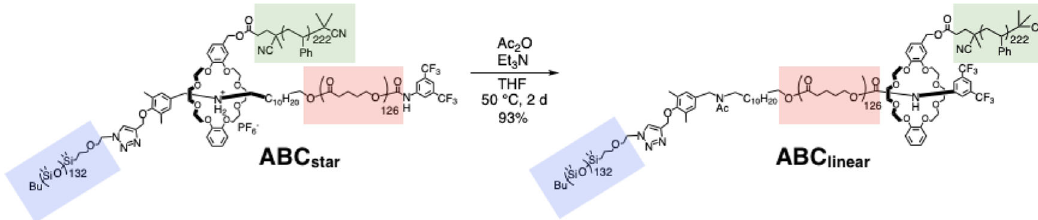
Fig. 3 Polymer topology transformation from star to linear. Transformation of the ABC terpolymer from a star-shaped ( ABC linear ) to a linear ( ABC linear )